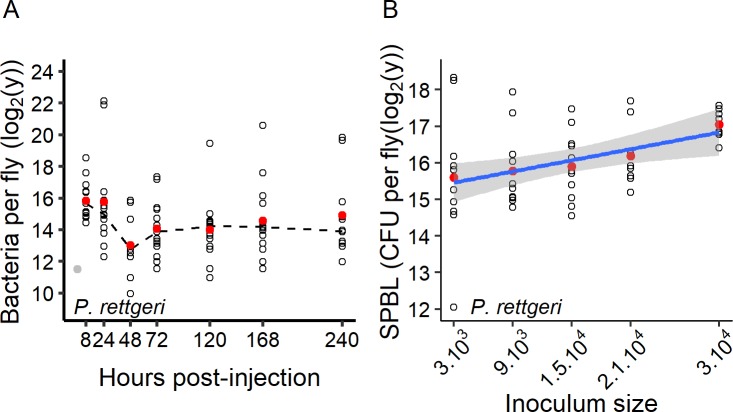
The chronic phase of infection is characterised by the Set Point Bacterial Load (SPBL).(A) The Set-Point Bacterial Load (SPBL) is stable up to 10 days post-injection (linear regression: Time: df = 1, F = 0.11, p=0.73). The grey dot represents the dose initiating the infection and the dashed line connects the medians. (B) The SPBL at seven days post-injection increases with the size of the inoculum (linear regression: Dose: df = 1, F = 8.15, p=0.006). The blue line represents the regression line.